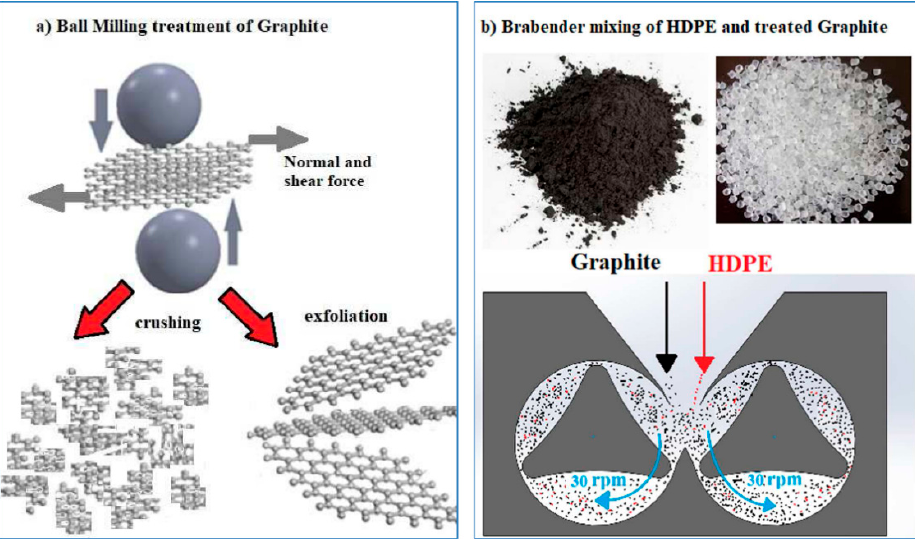
Figure 1. ( a ) A Solidworks ® representation of the graphite exfoliation/crushing by ball milling treatment. ( b ) The materials mixing in a Brabender Plasticorder.